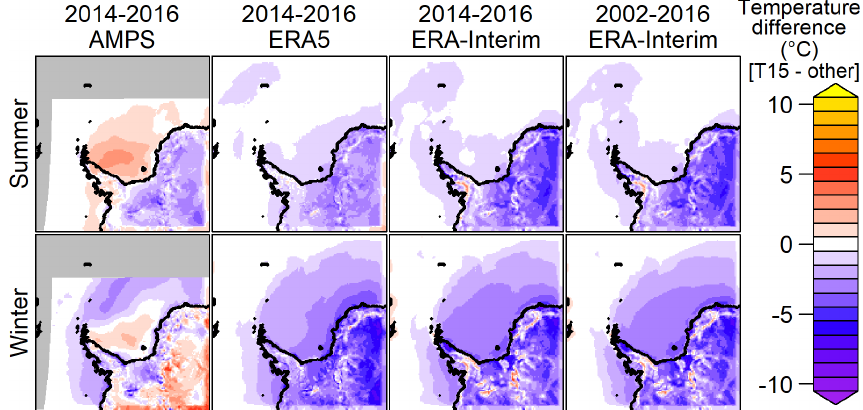
Figure 4. As Fig. 3 but for